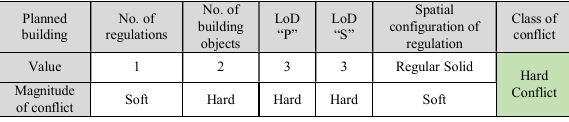
Table 7. Classification of the magnitude of overlooking regulation conflict